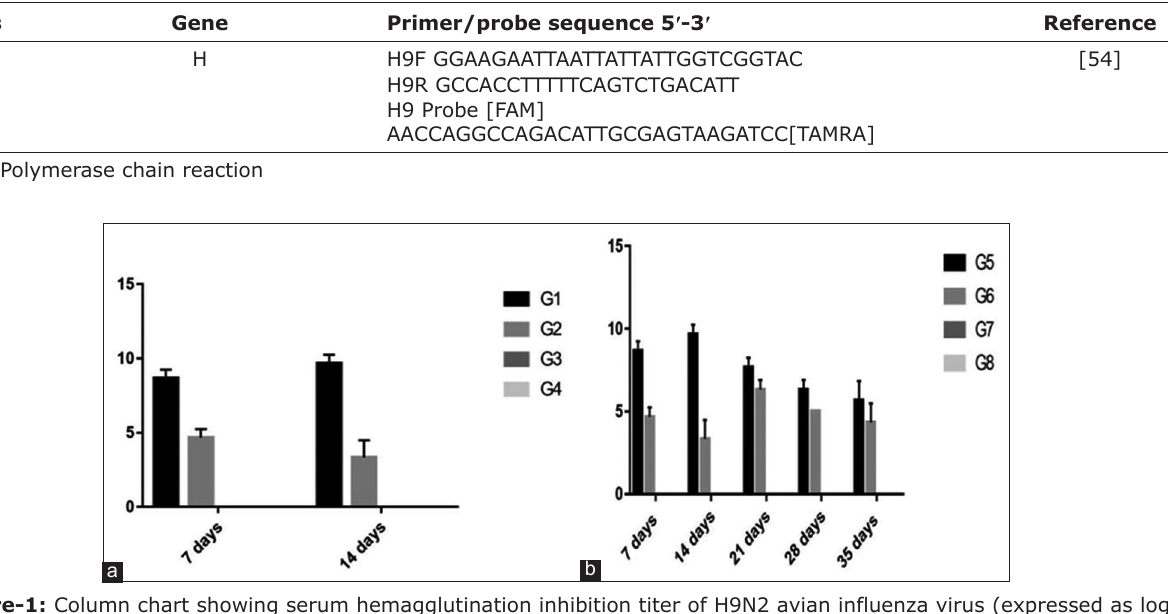
Figure-1: Column chart showing serum hemagglutination inhibition titer of H9N2 avian influenza virus (expressed as log 2). (a) Experiment 1, (b) Experiment